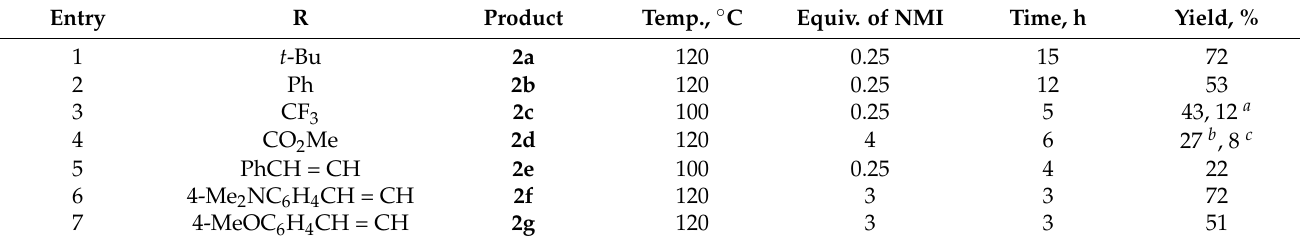
Table 2. The scope of enamino-substituted 4-pyrones 2 .